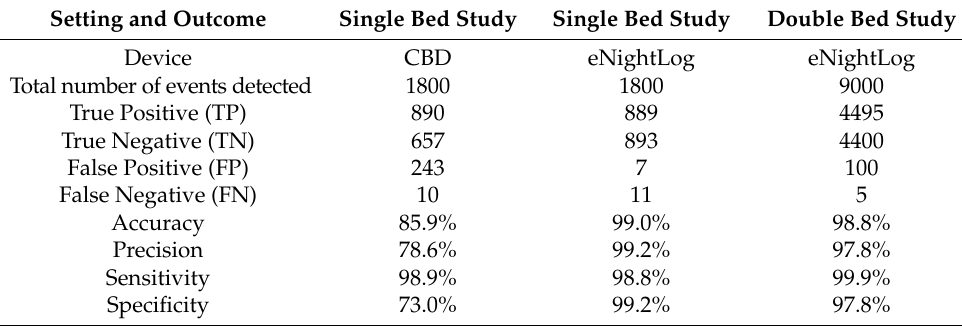
Table 5. Bed exiting event recognition results and evaluation results. Setting and